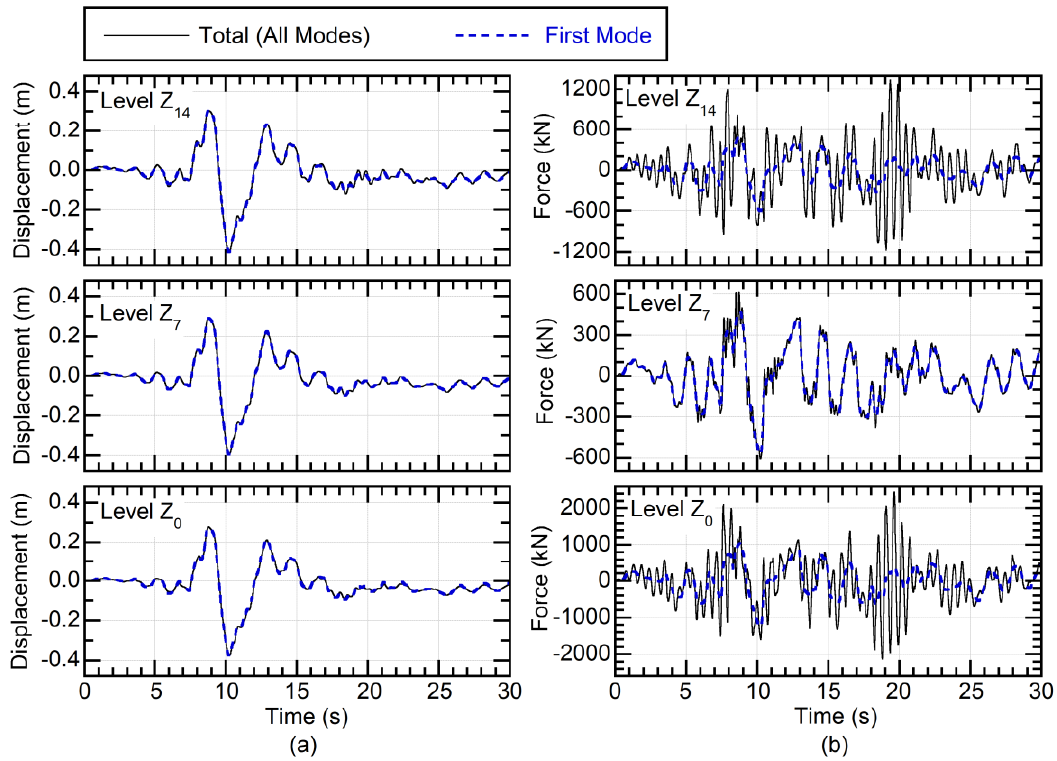
Figure 11. Time-history response of Model-14(Art-S09, 100%): ( a ) relative displacement and ( b ) restoring force.